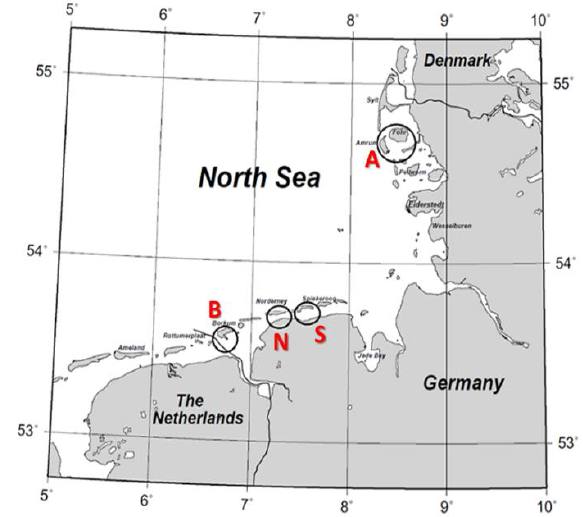
Figure 1. Four test sites on the German Wadden Sea coast: A: ‘Amrum’; S: ‘Spiekeroog’; N: ‘Norderney’; B: ‘Borkum’ (from northeast to